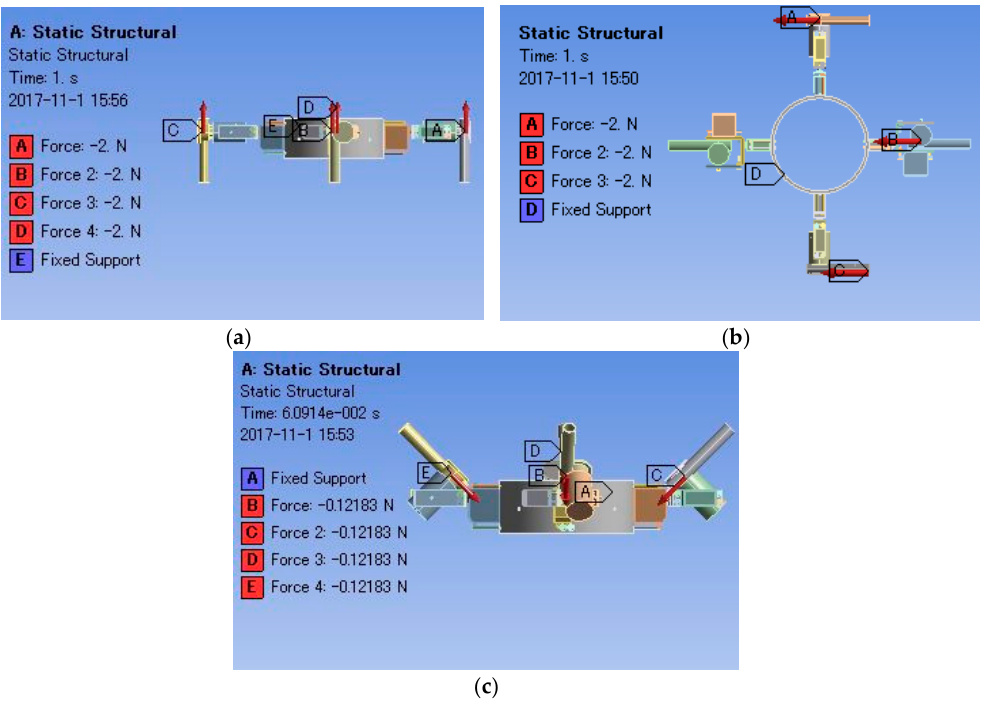
Figure 5. The pre-process of the static analysis. ( a ) Up motion; ( b ) Forward motion; ( c ) Down motion.